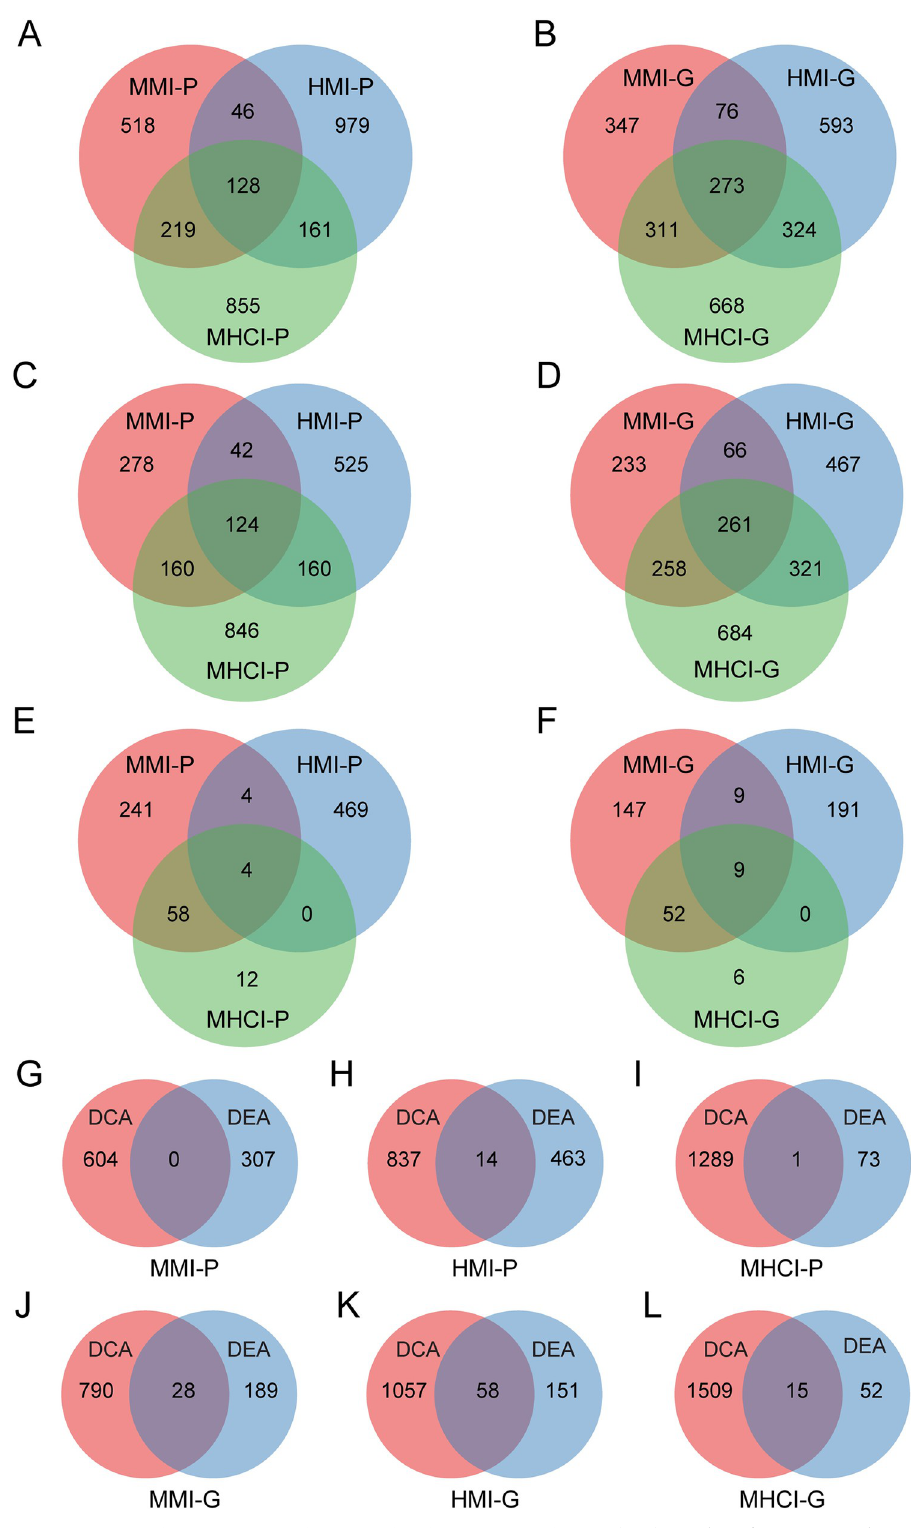
Fig 2. Overview of MMI-, HMI- and MHCI-related gene pairs and genes. (A-B) Number of gene pairs and genes identified by the IDEN framework. (C-D) Number of gene pairs and genes identified by the DCA method. (E-F) Number of gene pairs and genes identified by the DEA method. (G-I) Comparison of gene pairs identified by the DCA and DEA methods. (J-L) Comparison of genes identified by the DCA and DEA methods. https://doi.org/10.1371/journal.pcbi.1010744.g002 PLOS Computational Biology | https://doi.org/10.1371/journal.pcbi.1010744 December 19,